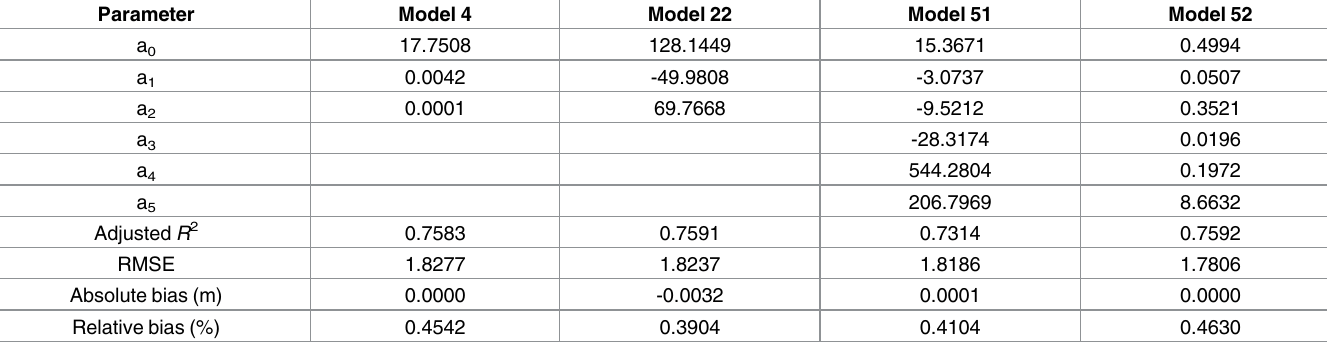
Table 6. Parameterestimatiesand fitting statistics of the final models by using all data. doi: 10.6084/m9.figshare.4956284.t006.